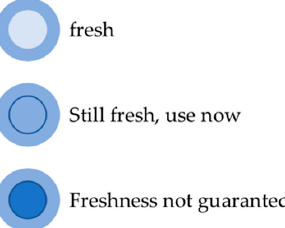
Figure 6. Principle of Lifeline’s Fresh-Check Indicator time temperature indicator (TTI), adapted from [35].